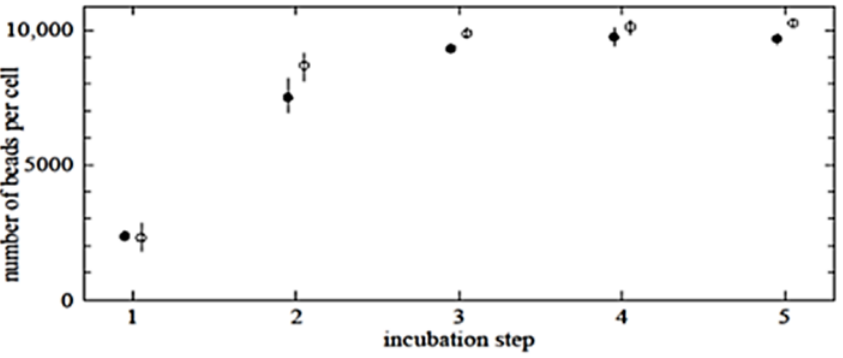
Figure 6. Maximum saturation level for target cells was determined by using multi-step incubation, as described in the Experimental Section. Solid and open circles represent the number of beads per untouched CD14- and CD3-positive cell, respectively.